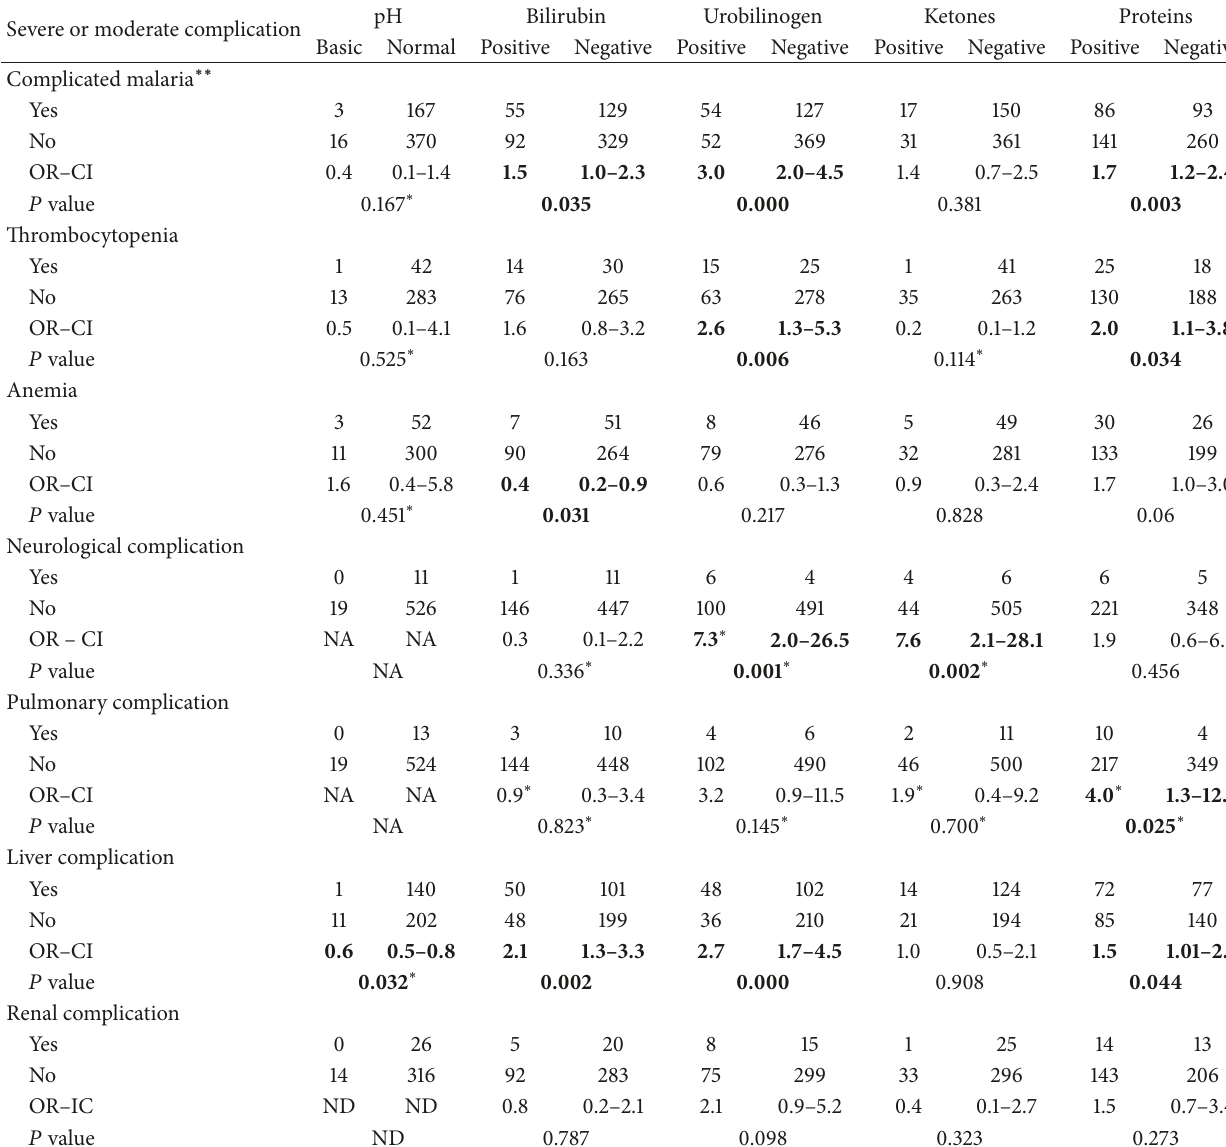
Table 4: Urinalysis variables according to the clinical